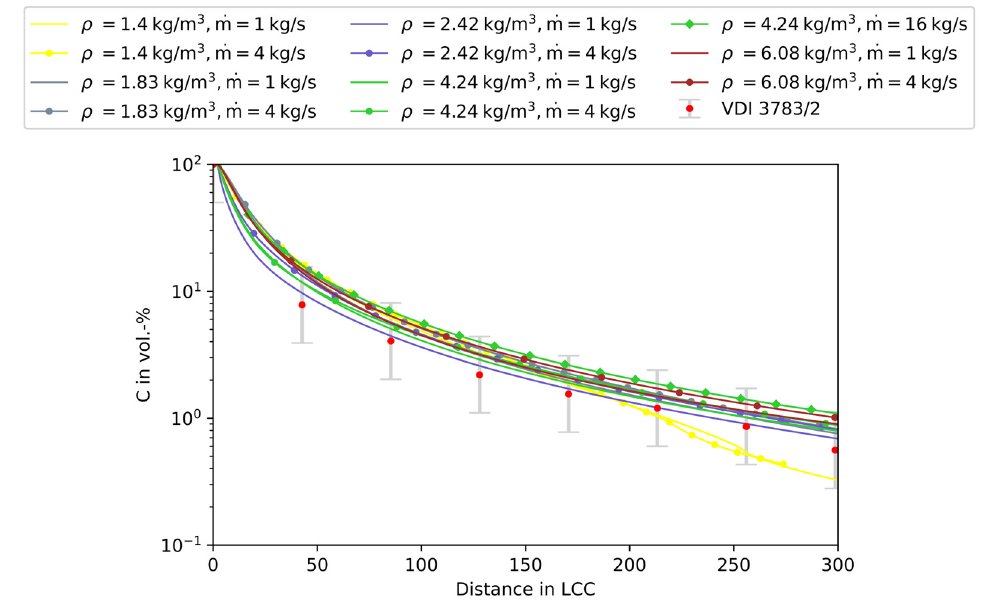
Figure 1. Concentration at the ground over the characteristic length scale from the source for the VDI 3783/2 predictions and the simulation results in non-built-up terrain.